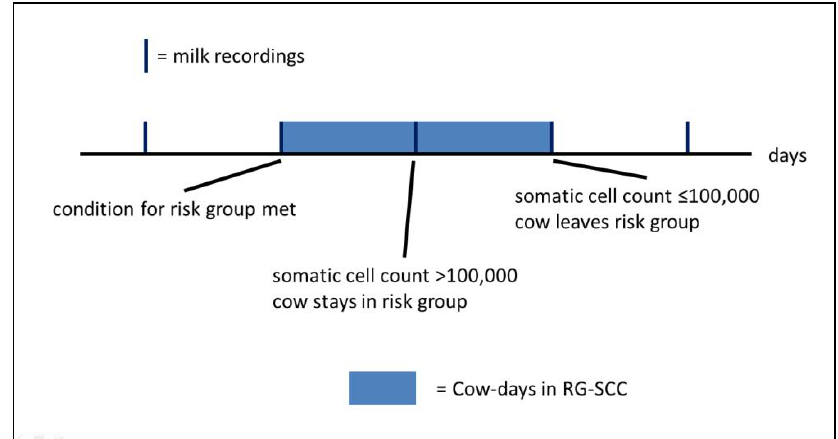
Figure 3. Schematic representation of the assignment of cow-days to the risk group RG-SCC (in- creased somatic cell count after monthly/weekly milk recording).